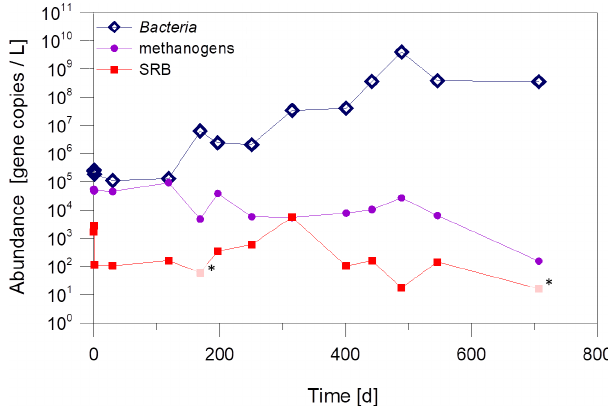
Figure 7. Abundance of Bacteria , methanogenic archaea and SRB in fluid samples from the plant exit at the geothermal plant Unter- haching since beginning of inhibitor dosage in August 2017. Pale values marked with an asterisk were below the sample specific de- tection limit. Quantification with qPCR with primers for the 16S rRNA gene ( Bacteria and methanogenic archaea) and the dsrA -gene for sulfate-reducing